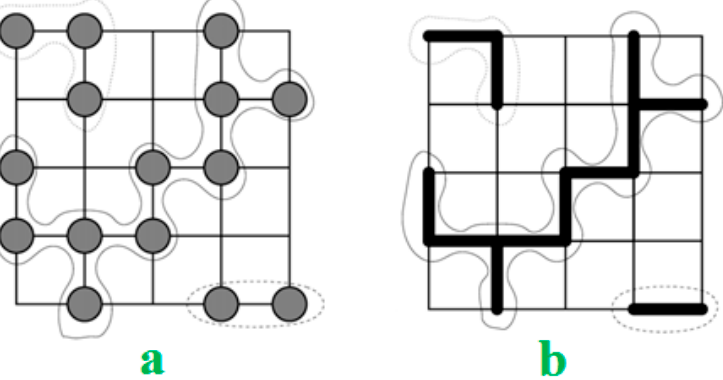
Figure 2. ( a ) Site and ( b ) bond percolation models on a square Figure 2 . ( a ) Site and ( b ) bond percolation models on a square lattice.